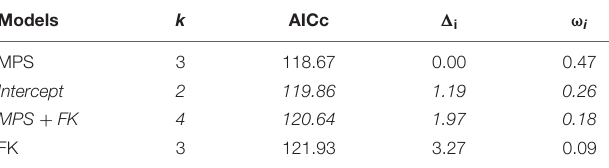
TABLE 5 | Influence of MPS and FK on RTU (GLMM